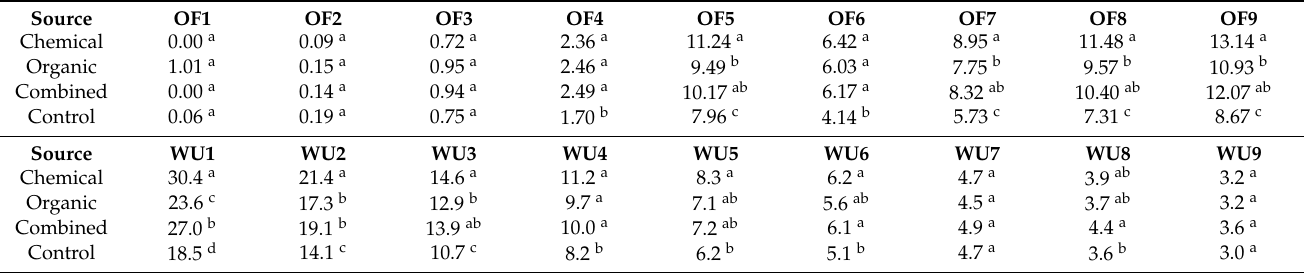
Table 12. Number of open flowers (OF), water uptake (WU), flower weight (FW), senescent flowers (SF) in a period of nine days (1–9) in vase of tuberose grown with different sources of